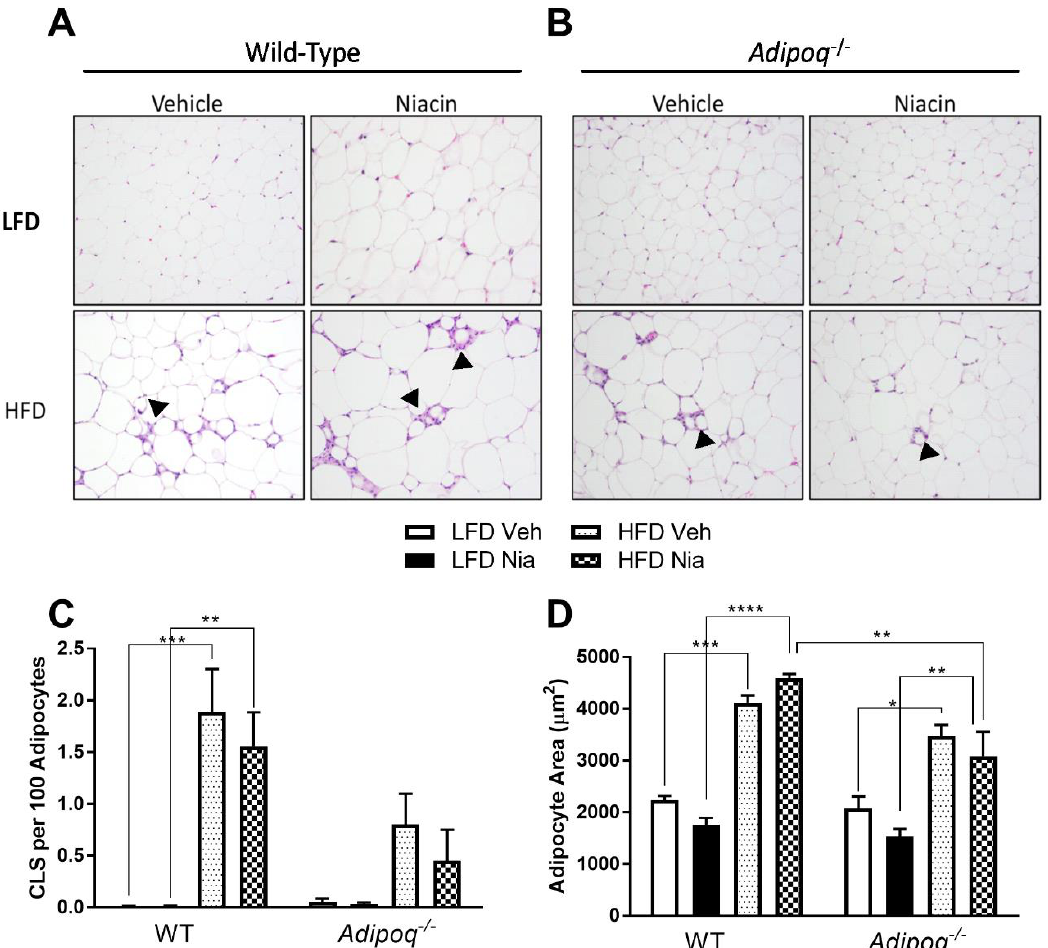
Figure 4. Effects of HFD and niacin on the development of crown-like structures (CLS) in EWAT. Images of hematoxylin and eosin (H&E)-stained sections of EWAT depicting CLS density for ( A ) wild-type and ( B ) Adipoq -/- mice. Number of CLS per 100 adipocytes ( C ). Mean adipocyte area ( D ). Arrowheads indicate CLS. Data are presented as mean + SEM. * p ≤ 0.05; ** p ≤ 0.01; *** p ≤ 0.001; **** p ≤ 0.0001; WT LFD Veh, n = 4; WT LFD Nia, n = 3; WT HFD Veh, n = 3; WT HFD Nia, n = 3; Adipoq -/- LFD Veh, n = 3; Adipoq -/- LFD Nia, n = 3; Adipoq -/- HFD Veh, n = 4; Adipoq -/- HFD Nia, n = 4.